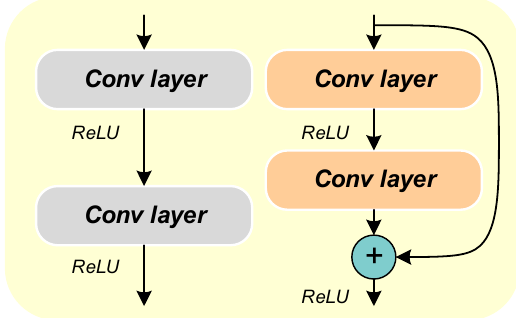
Figure 6. Comparison of a plain block and residual block.